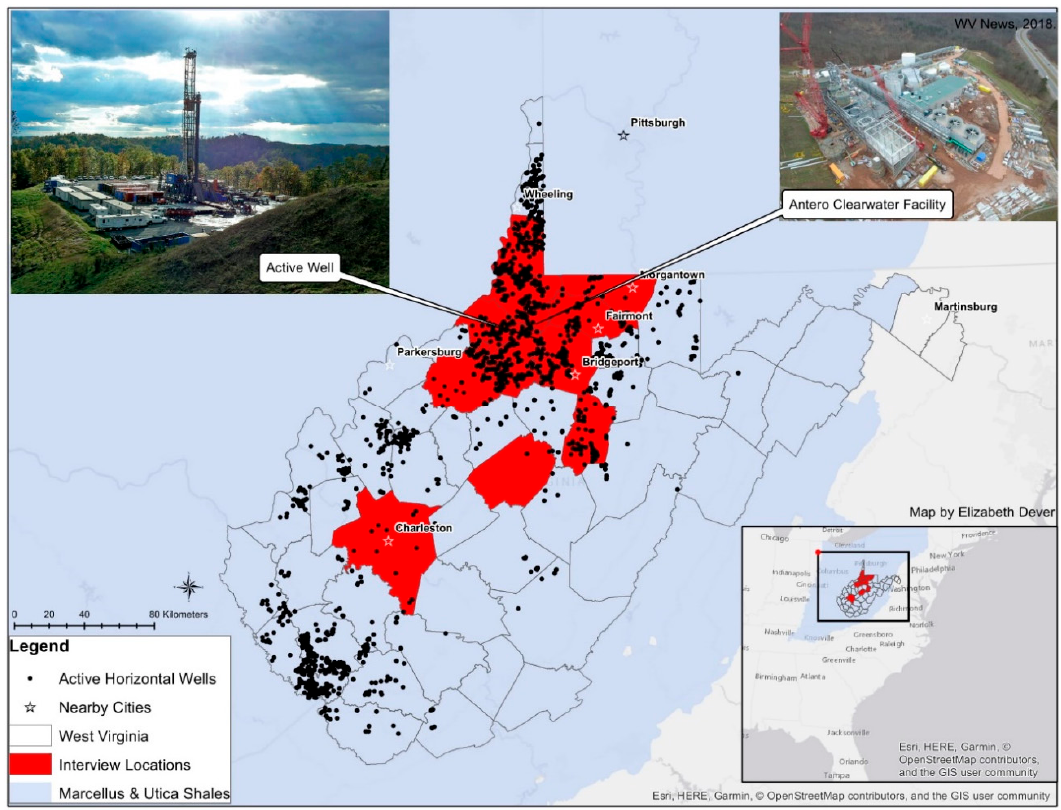
Figure 2. Map of West Virginia by Elizabeth Dever depicting locations of active horizontal wells, nearby cities, and interview locations within the Marcellus and Utica shale.